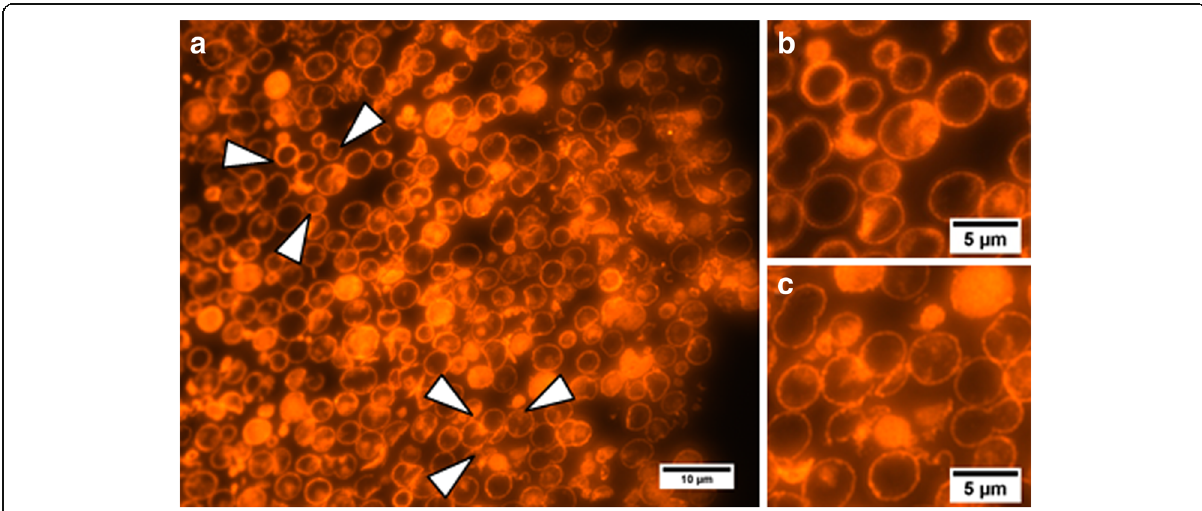
Fig. 5 Microphotographs of sections of the polyelectrolyte microcapsules encoded with quantum dots. The arrows in ( a ) indicate the areas shown in ( b , c ) at a higher